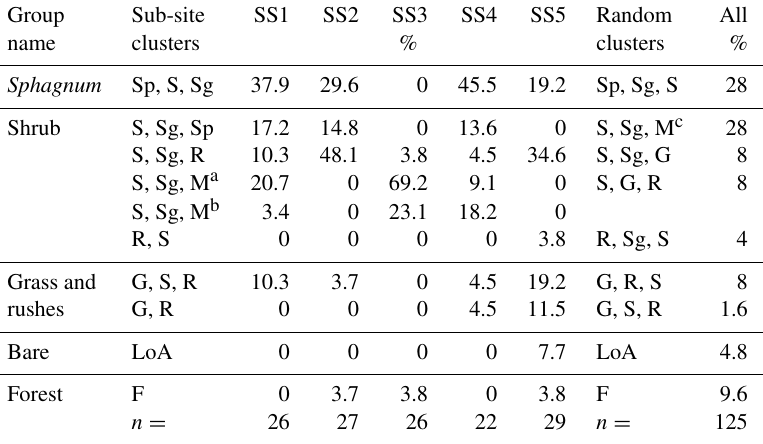
Table 2. Percentage proportion of clusters derived from hierarchical cluster analysis based on plant functional types (PFTs) represented in the polygons of the five sub-sites and the random polygons. Clusters are defined by the dominant (first) and co-dominant (subsequent) PFTs. PFT notations: Sp – Sphagnum ; S – shrub; Sg – sedges; M – moss; G – grasses; R – rushes; F – forest; LoA – low or absent vegetation (brash, bare peat following tree felling or restoration activities, etc.). n : number of polygons. For data visualisation, the sub-site and random clusters were then grouped into five plant functional groups based on the dominant PFTs: Sphagnum , shrub, grass and rushes, bare peat, and forestry. Clusters dominated by rushes ( R ) were incorporated into the shrub group for data visualisation given their low number and shrub co-dominance. Bare peat and forestry were retained despite low numbers, as their vegetation is associated with specific management intervention. Footnotes describe further differences between clusters (Tables S2 and